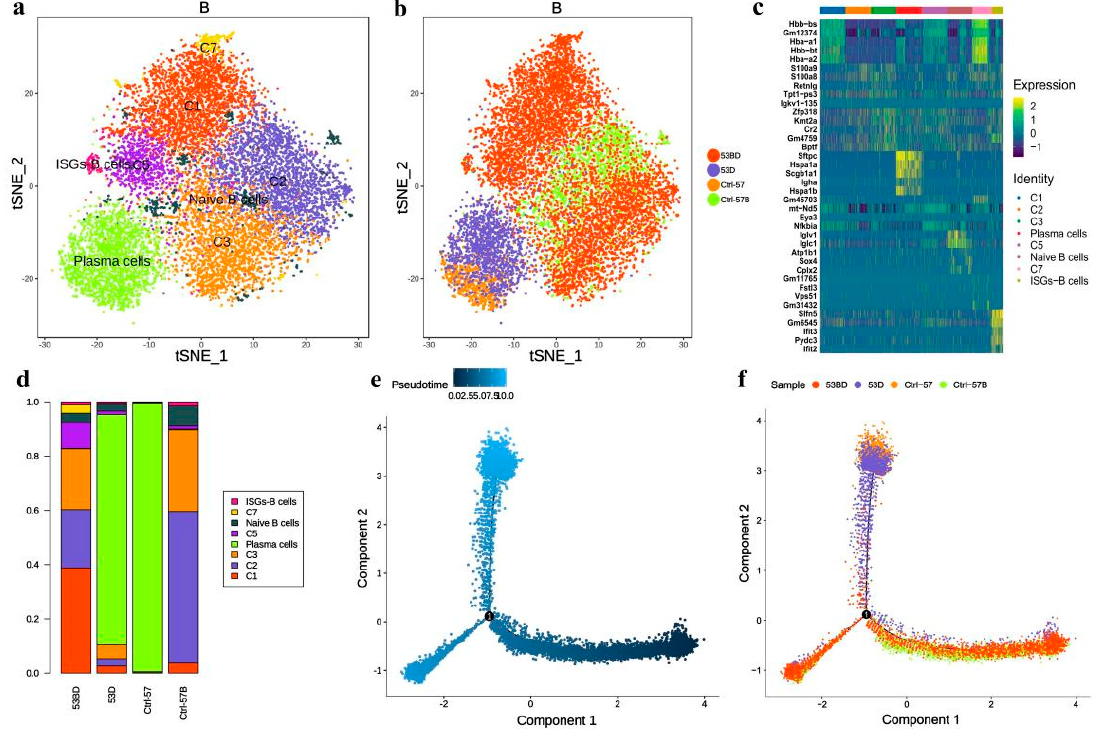
Figure 8. Single-cell transcriptional profiling of B cells. ( a , b ) t-SNE of B cells profile with each cell color-coded for associated cell types and sample type. ( c ) The heatmaps of hierarchically clustered top 10 differentially expressed genes (DEGs) across 8 groups of B cells. The gene names were listed to the right. ( d ) The fraction of B cells subtypes for each sample. Simulation of the development trajectory of B cells and the analysis of gene expression pattern inferred by Monocle2, ( e ) pseudo- trajectory of B cells, ( f ) cell source transition.